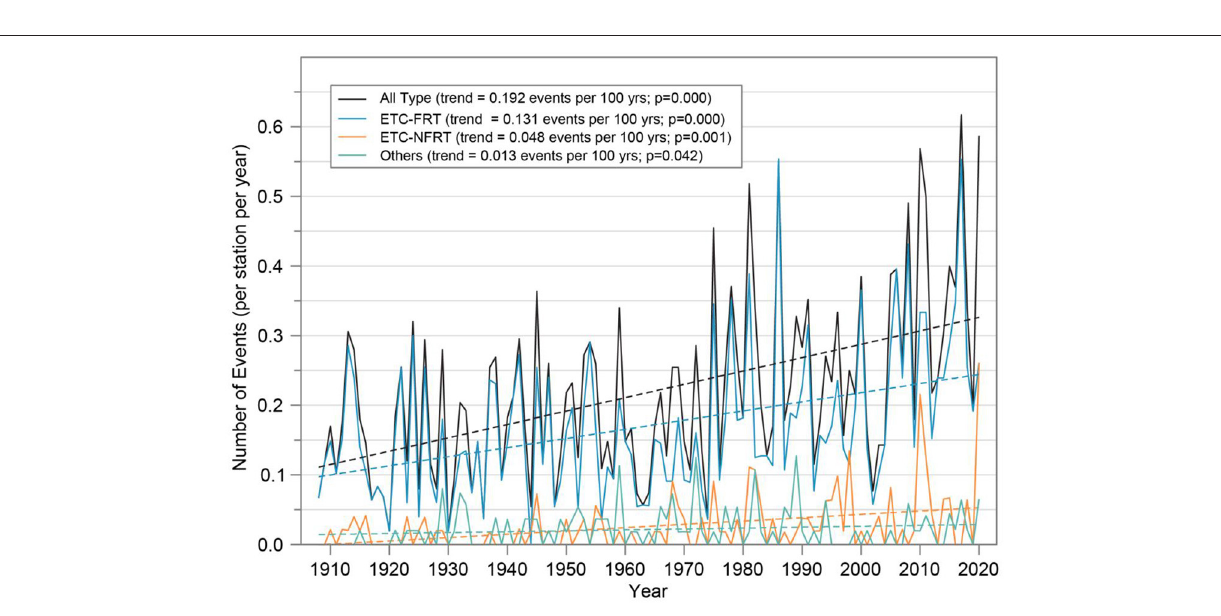
FIGURE 6 | Annual time series of the overall number of extreme events per station (“All Type”; black line), events caused by one of the ETC fronts (“ETC-FRT”; blue), events caused by an ETC not near a front (“ETC-NFRT”; orange), and events caused by all other types (“Others”; green). Dashed lines indicate linear least-squares fits to the annual data. The trend values and p -values of the trend lines are displayed in the